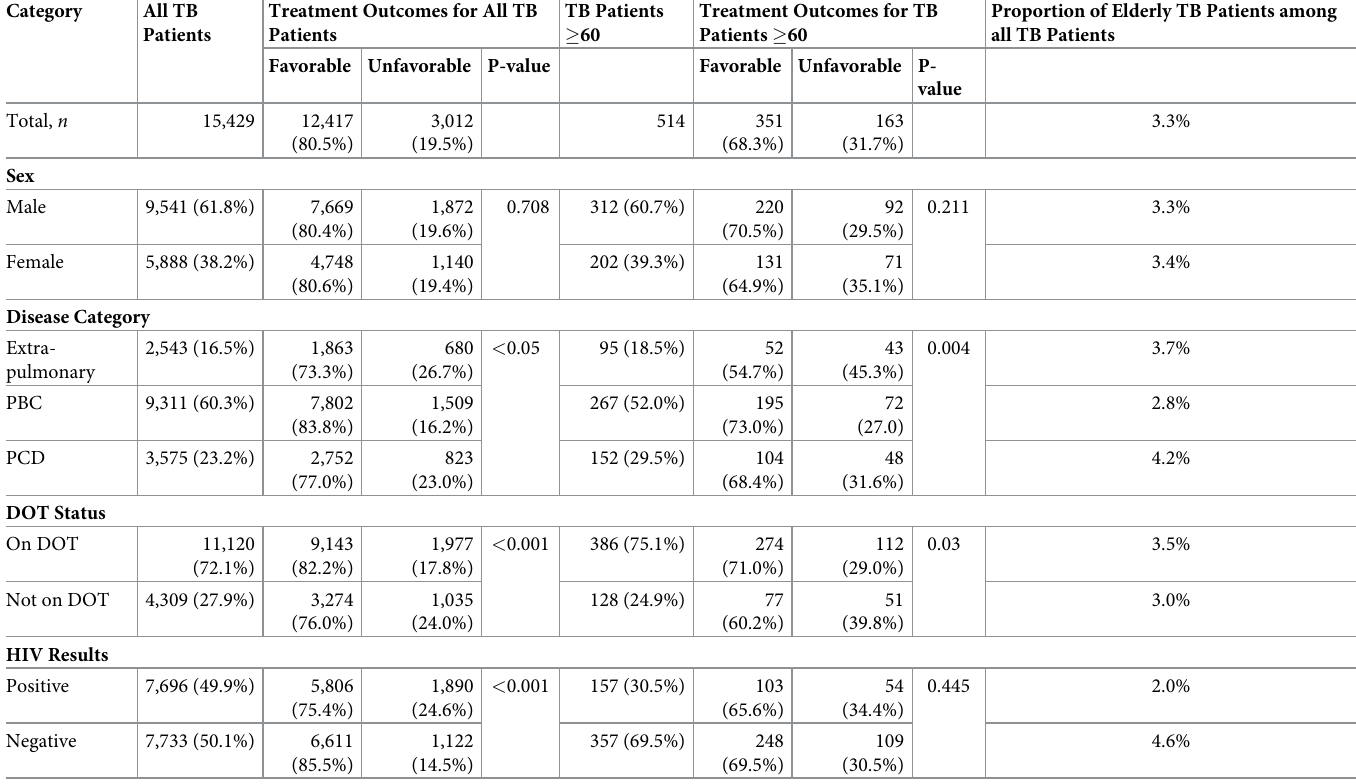
Table 1. Characteristics of elderly TB patients registered during January 2014 to December 2015.